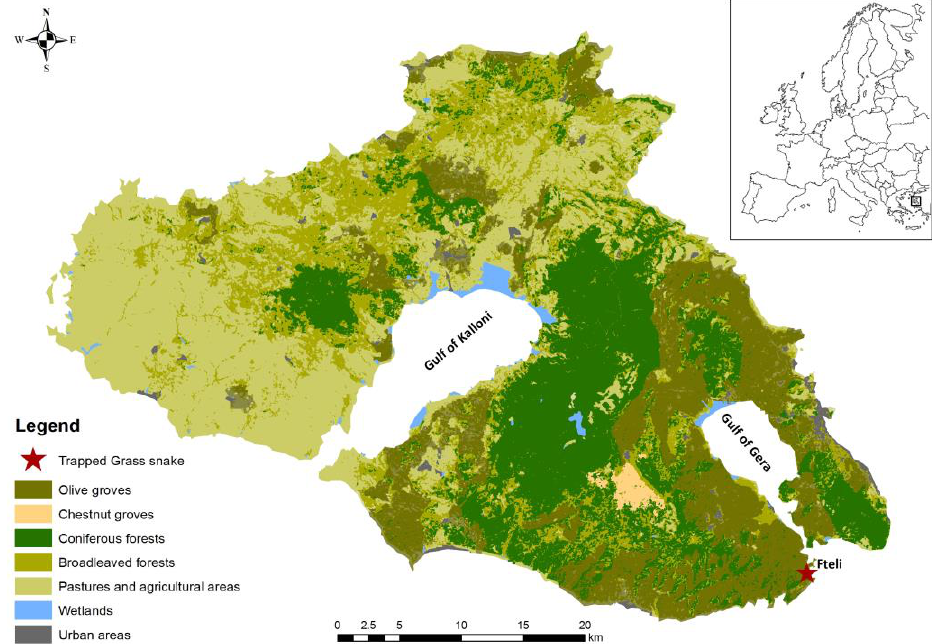
Figure 3. Distribution map concerning the main land cover types of the island of Lesvos along with the locality of the trapped Grass